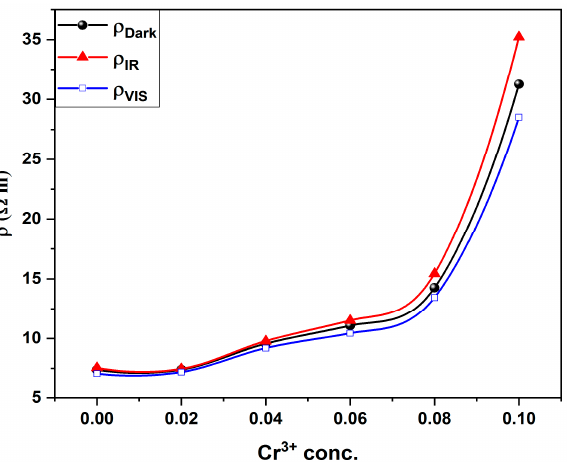
Figure 6. Resistivity of (dark, IR and Vis) against Cr 3+ concentration for all investigated thin films.